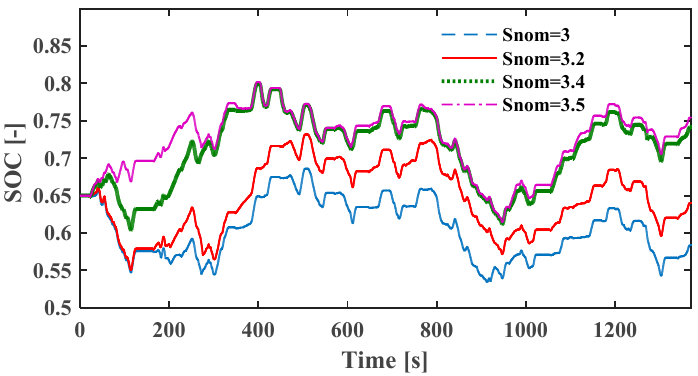
s under the Urban Dynamometer Driving s under UDDS.